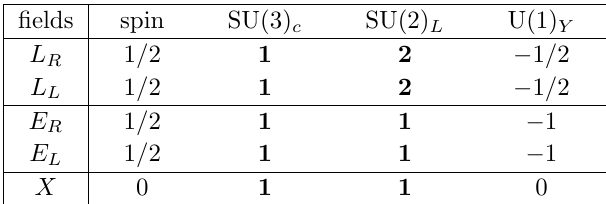
Table 2 . Matter content in the scalar DM model. The subscripts L; R for the fermions represent their chiralities. L and E , are vectorlike fermions to respect the anomaly-free